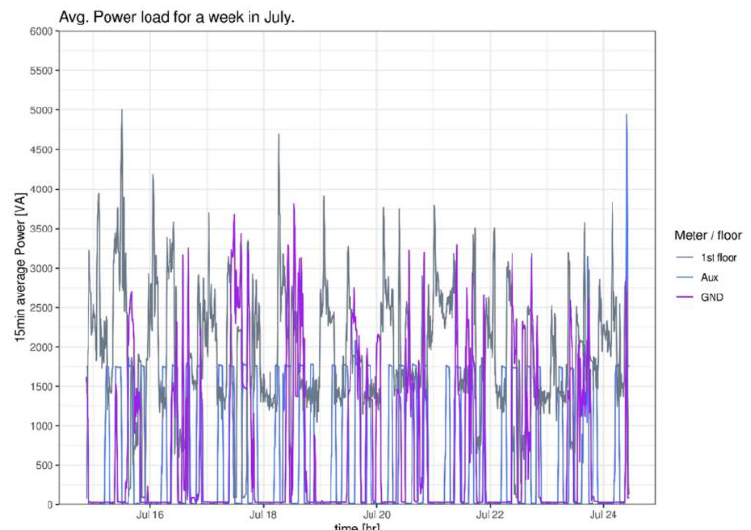
Figure 16. The 15-min average maximum power demand for the ground floor, first floor, and the auxiliary meter for a week in July 2019.